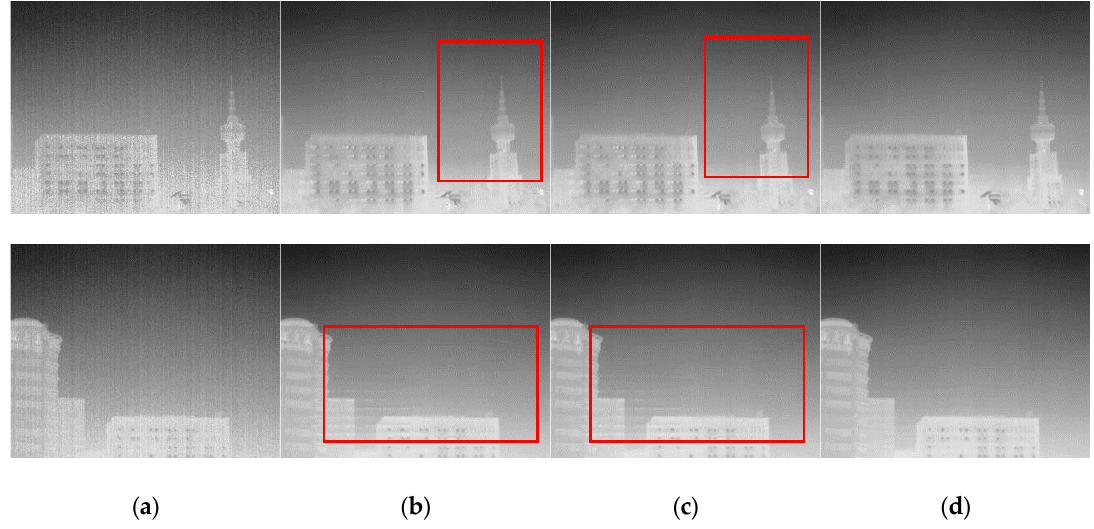
Figure 5. Typical scenes in the correction process: ( a ) uncorrected image; ( b ) Gated–least mean square (Gated-LMS); ( c ) combined spatial and temporal deghosting–least mean square(ST-LMS); ( d ) our image. The top row is the 954th frame, when the imager jittered toward the outdoor scene. The bottom row is the 959th frame when the imager suddenly move.